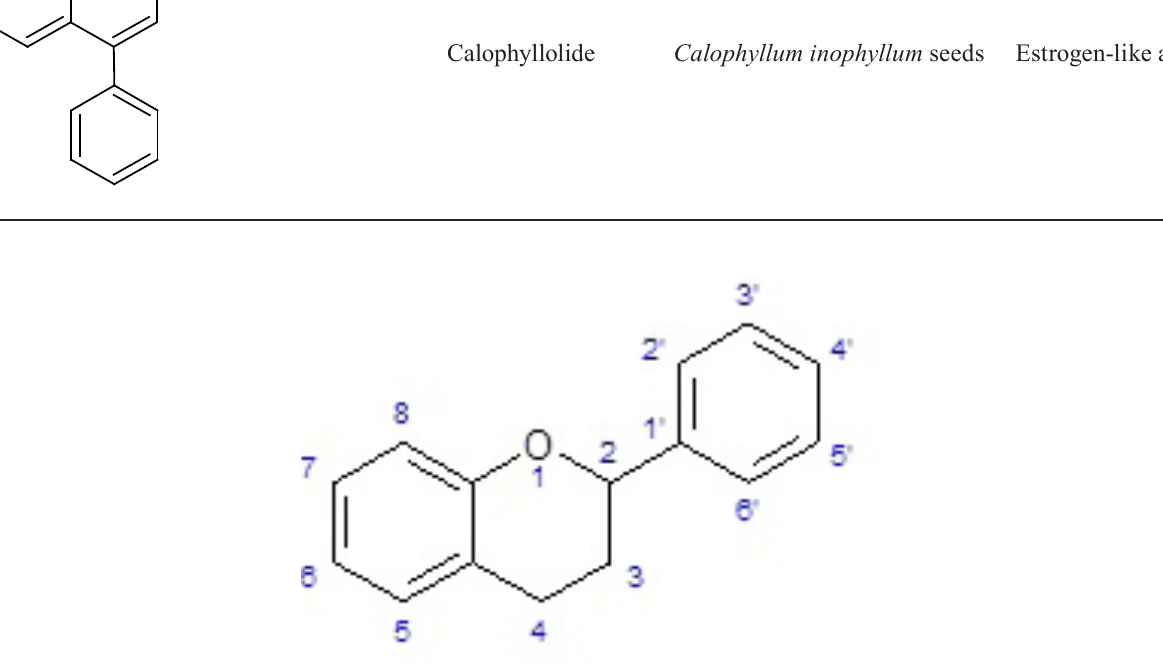
FIGURE 1 - General structure of